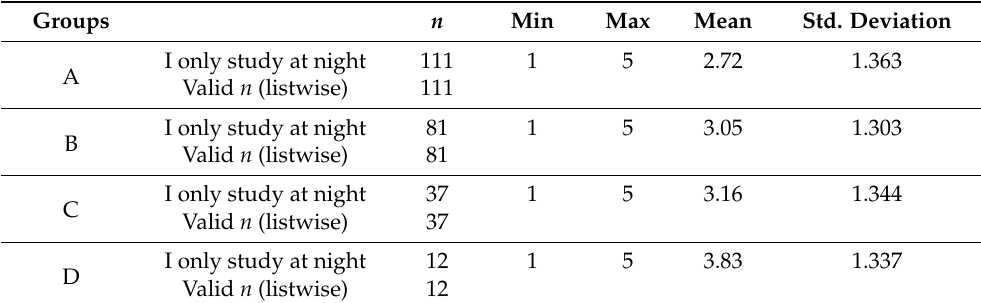
Table 3. Students’ position on learning